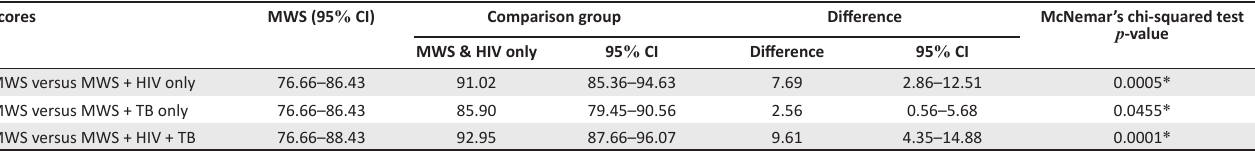
TABLE 3 : Comparison of the overall sensitivity of the modified Wells score versus the adjusted modified Wells score for HIV/tuberculosis as additional risk factors. Scores